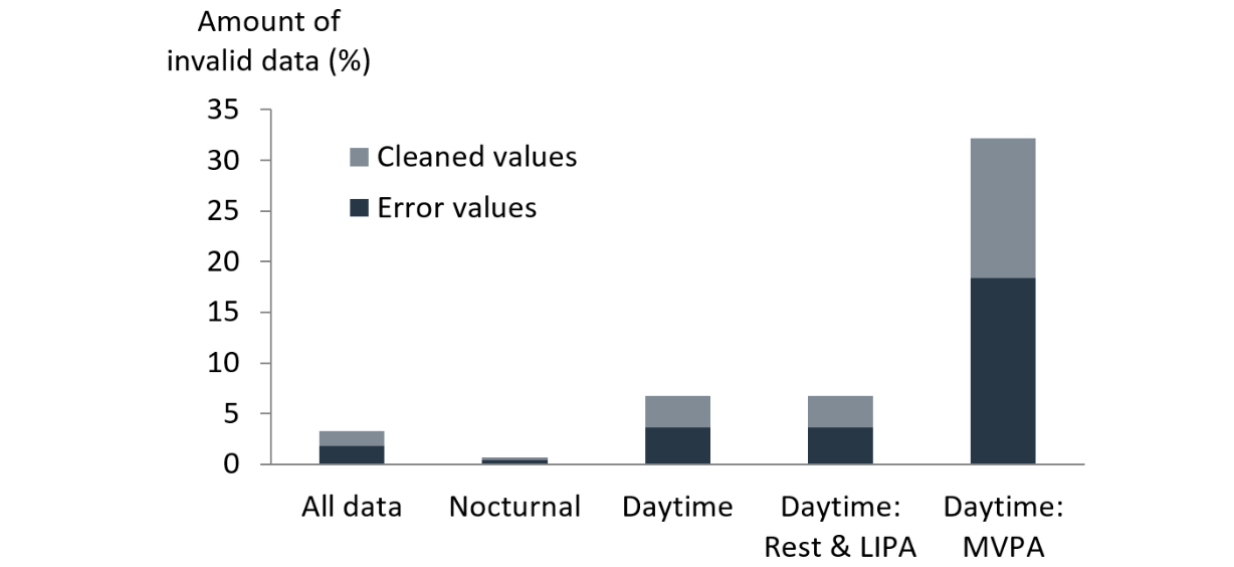
Figure 3. The amount of invalid data of continuous peripheral blood oxygen saturation (SpO 2 ) measurements for different activities. LIPA: low-intensity physical activity; MVPA: moderate-to-vigorous physical